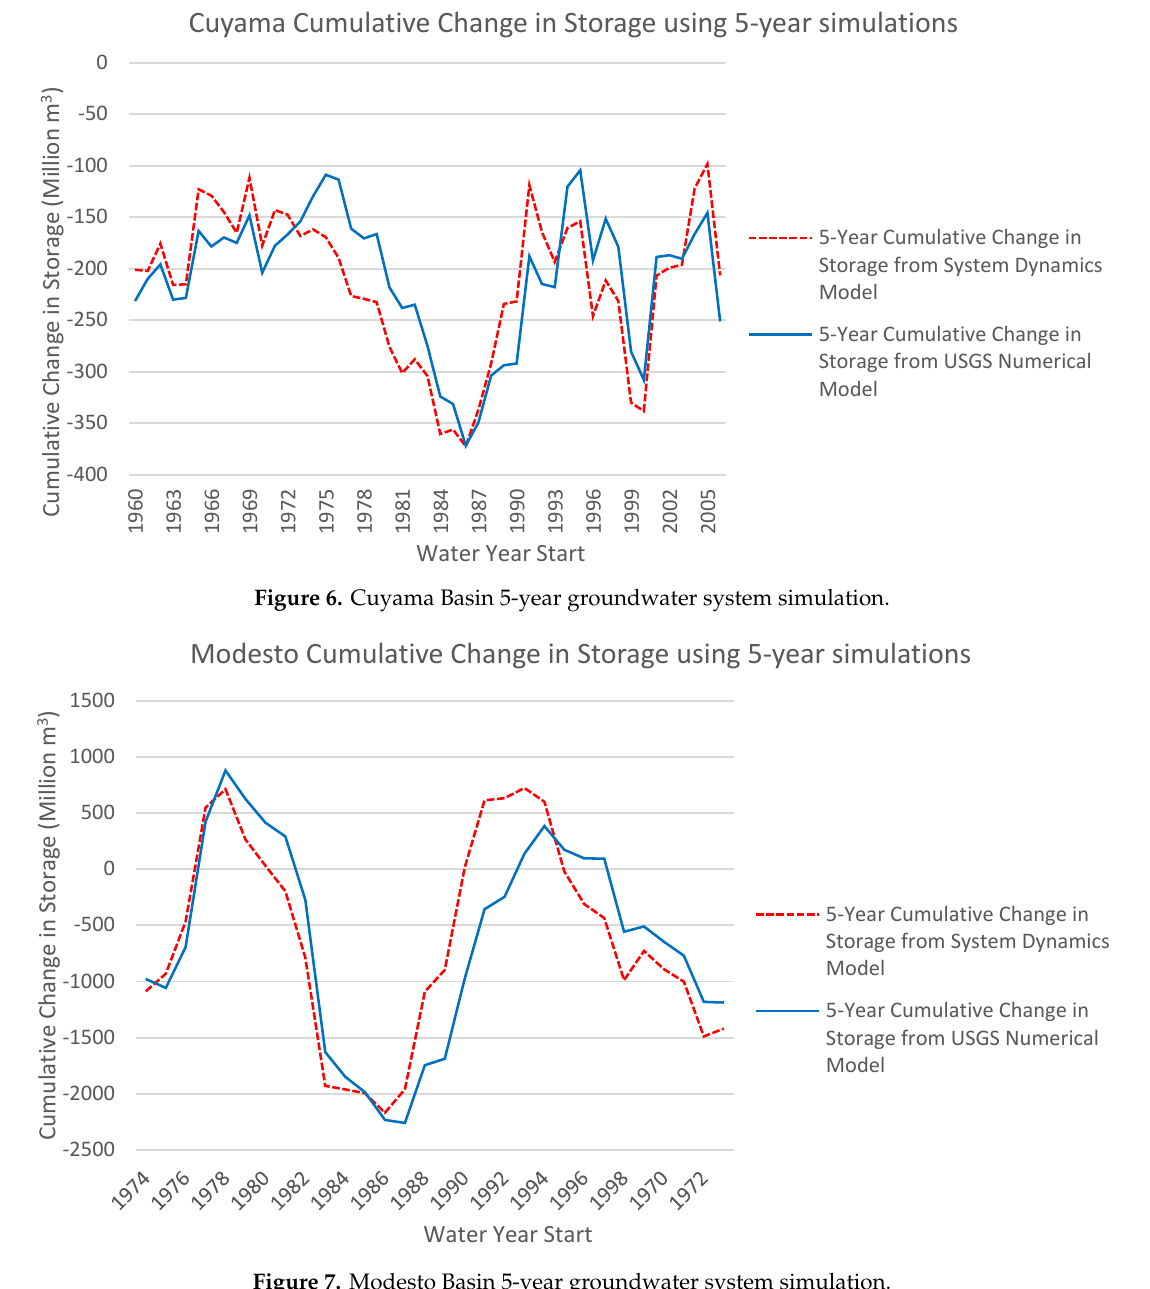
Figure 7. Modesto Basin 5-year groundwater system simulation.